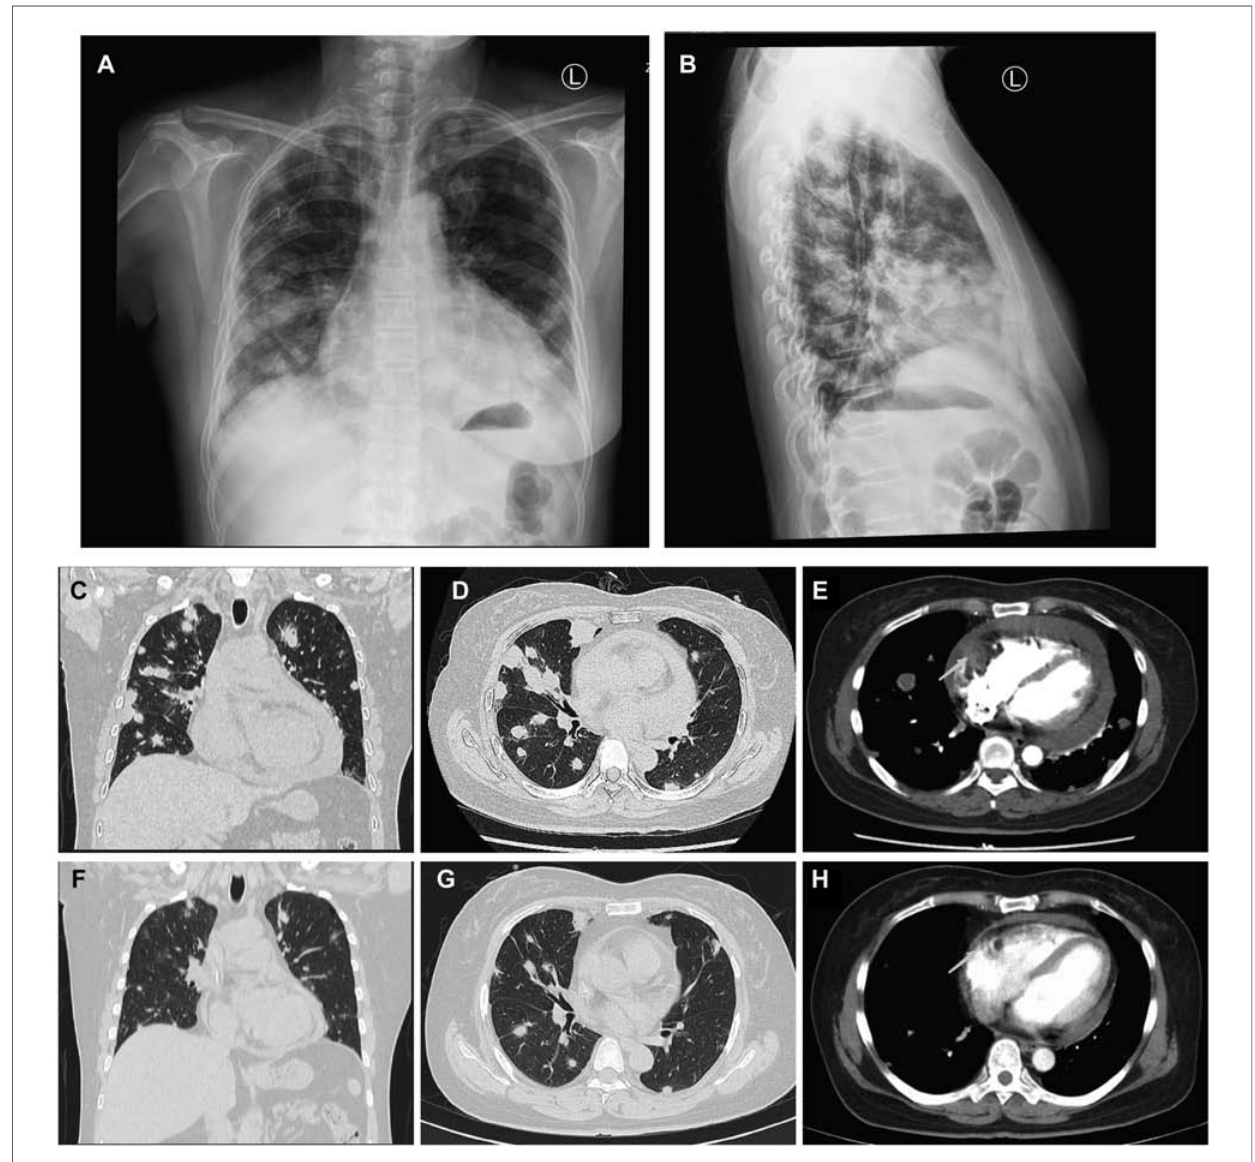
FIGURE 3 Comparison of lung metastases and cardiac mass before and after chemotherapy of Case2. ( A,B ) Frontal and lateral Chest x-ray demonstrated extensive pulmonary lesions. ( C ) Chest CT at coronal view and ( D ) axial view revealed severe lung metastases. ( E ) Contrast-enhanced Chest CT reveals a mass lesion (arrow) along the superior and posterior right atrial wall without enhancement. After 5 courses of chemotherapy, the number of lung metastases ( F,G ) was less than before ( C,D ), and the lateral wall of the RA ( H ) has no occupied (arrow) compared to earlier ( E